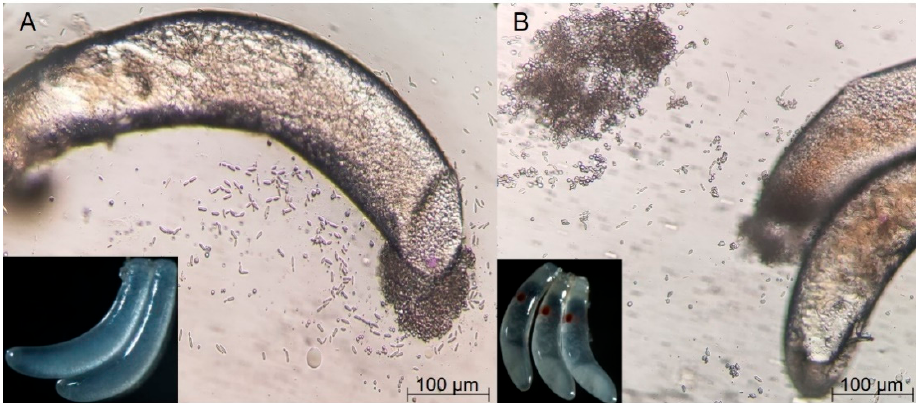
Figure 1. Difference of appearance and Yeast-like symbiont (YLS) number in fertilized and non-fertilized eggs of Nilaparvata lugens : ( A ) non-fertilized eggs; ( B ) fertilized eggs.